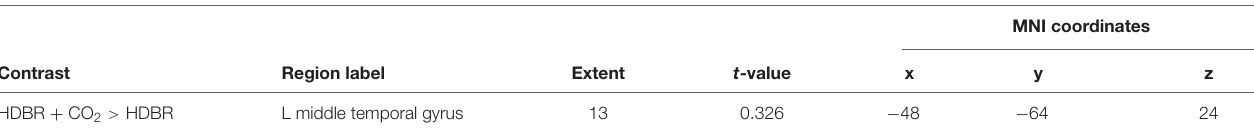
FIGURE 6 | Differences in normalized slope of DTCost of brain activation between HDBR + CO 2 and HDBR. (Top) Values for normalized slope of DTCost of brain activation in the left middle temporal gyrus for the HDBR + CO 2 (left) and HDBR (right) cohorts. Blue, individual values. Orange, average values. Analyses were conducted at an uncorrected alpha level of p < 0.0001. (Bottom) Left middle temporal gyrus cluster that exhibited a significant difference in normalized slope of DTCost of brain activation between the HDBR and HDBR + CO 2 cohorts. TABLE 3 | HDBR vs. HDBR + CO 2 between-group